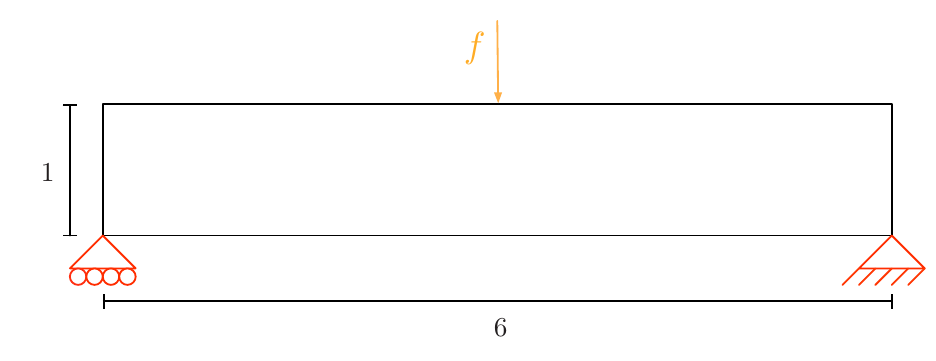
Fig. 2 Setting of the two-dimensional MBB beam example.